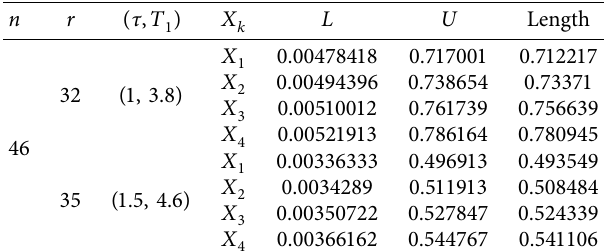
Table 4: 95% Bayesian predictive intervals of future order statistics when β � 3, a � 0 . 7, b � 0 . 9, c � 0 . 9, and d � 0 . 6 (two-sample